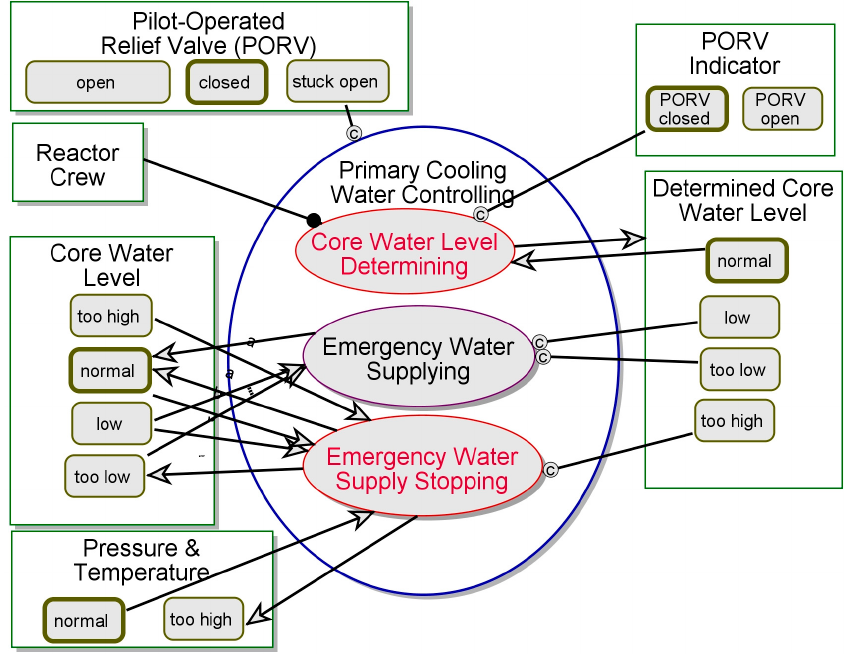
Figure 11. Primary Cooling Water Controlling—CPG-Aware Model.